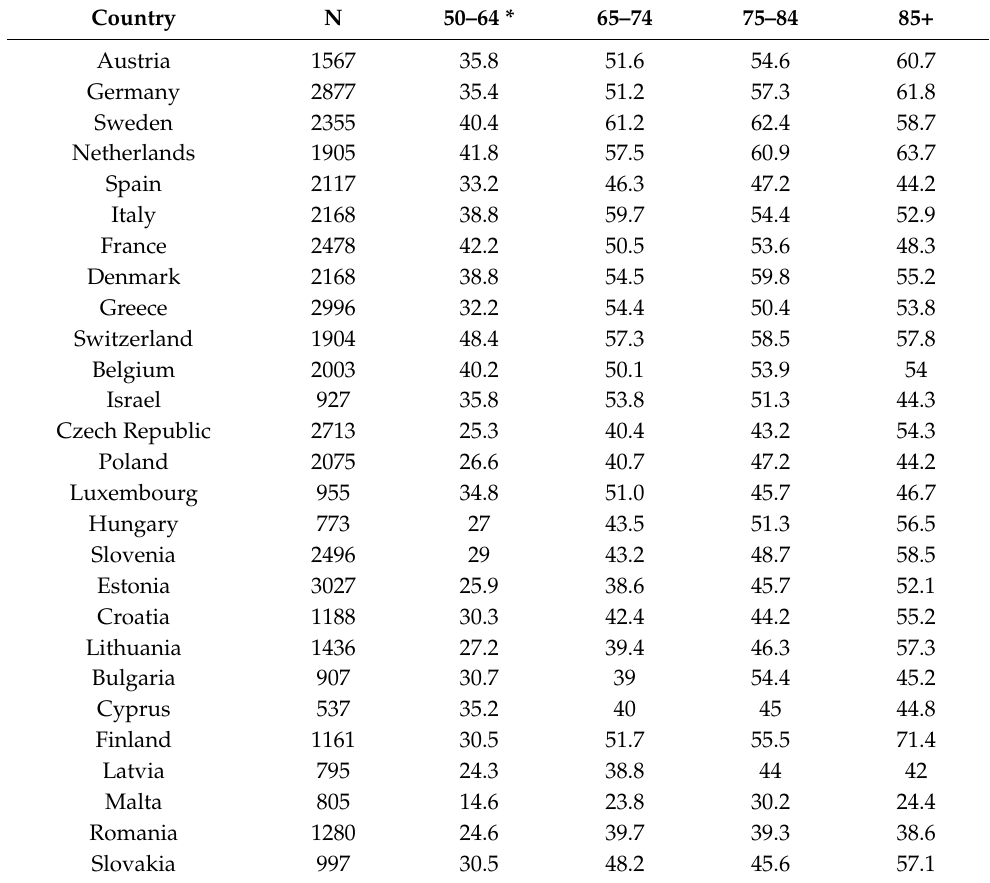
Table 4. Share of population with the Body mass index in the range defined as normal for a certain age (age 50–64 *: 18.5–24.9 kg/m 2 ; age 65+: 21–27.5 kg/m 2